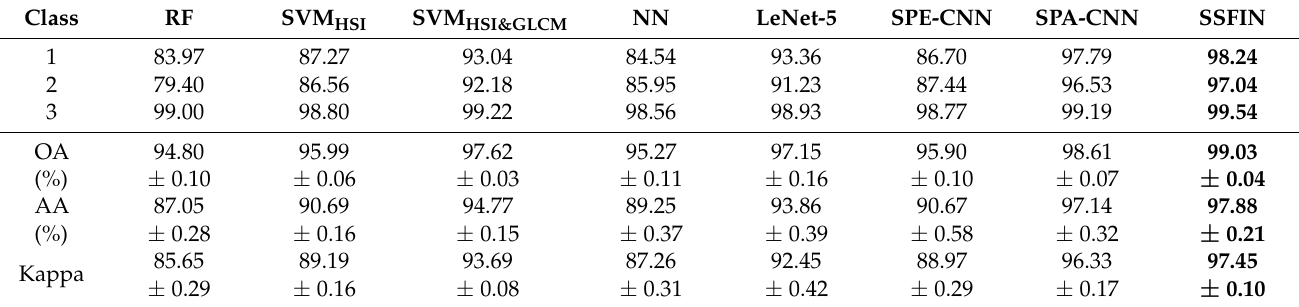
Table 8. Classification results of different methods for dataset 2.